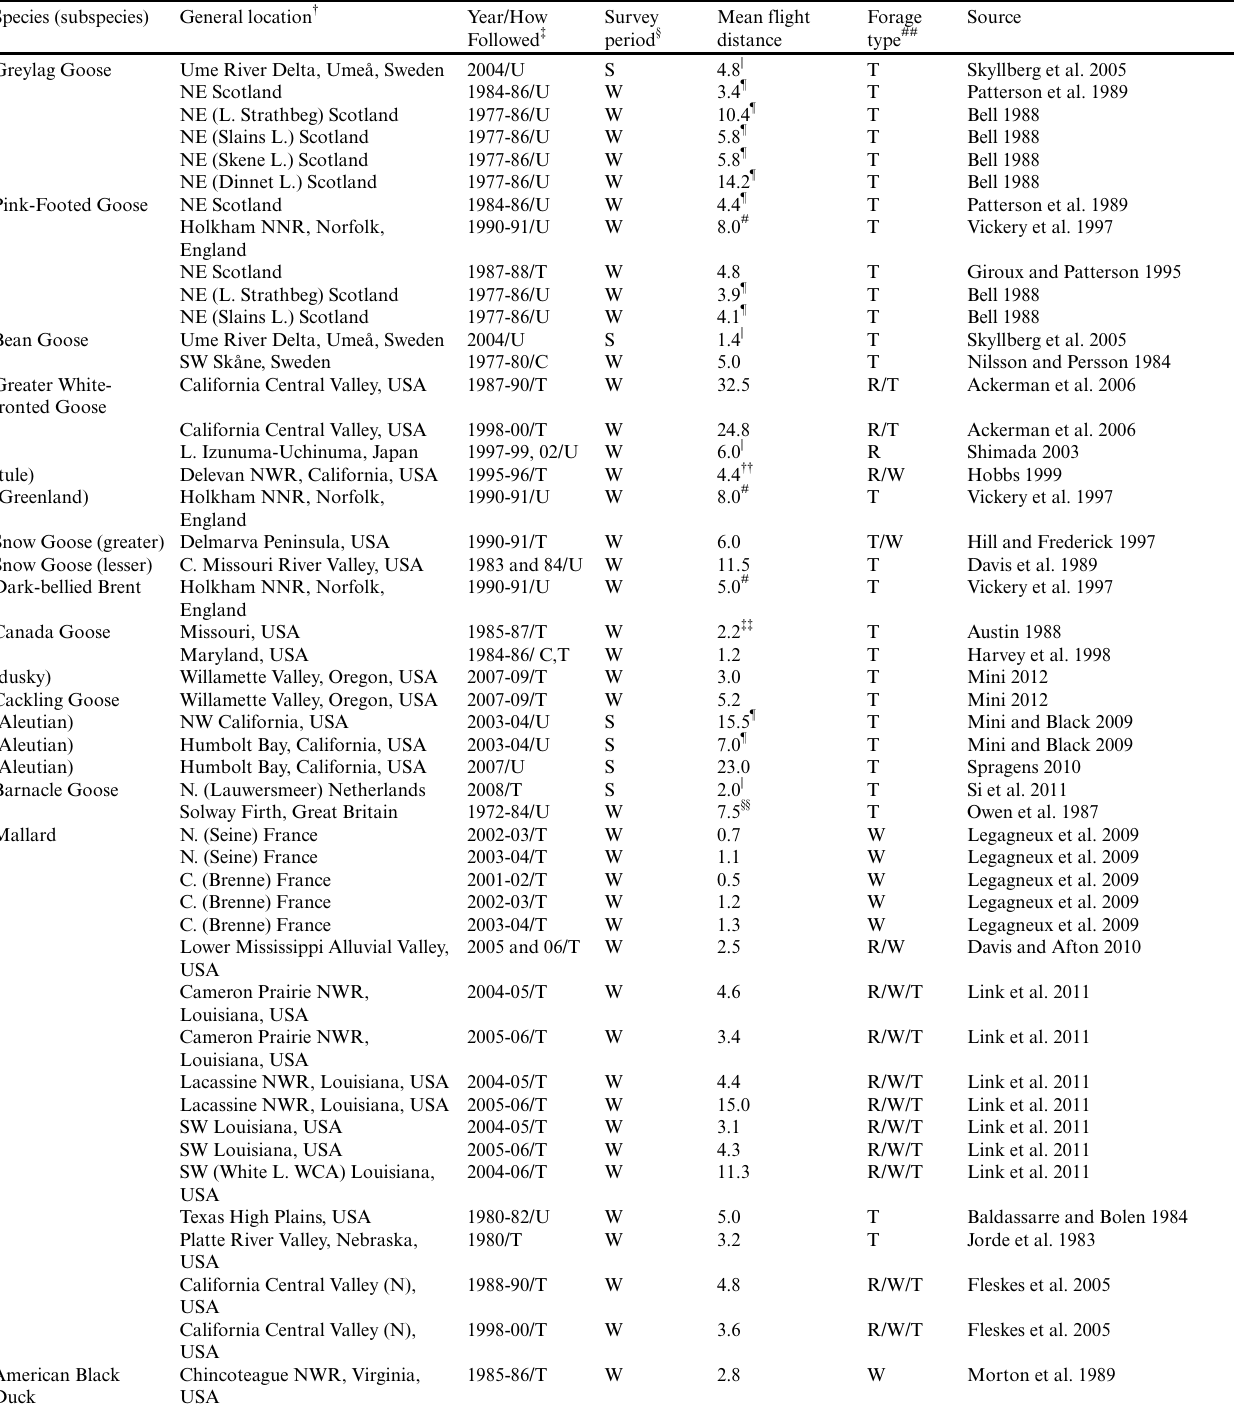
Table 1 . Distances flown (flight distance) between roost site to feeding site for waterfowl during migration and winter. When significant differences between age cohorts or year were reported, we included them as independent foraging flight distance values in our review and subsequent analyses. Scientific names for all species listed in Appendix